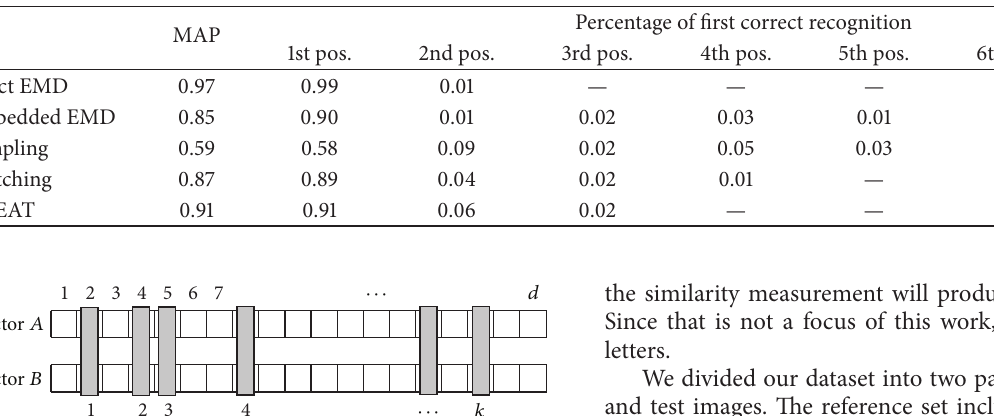
Table 7: Results of 5 methods.